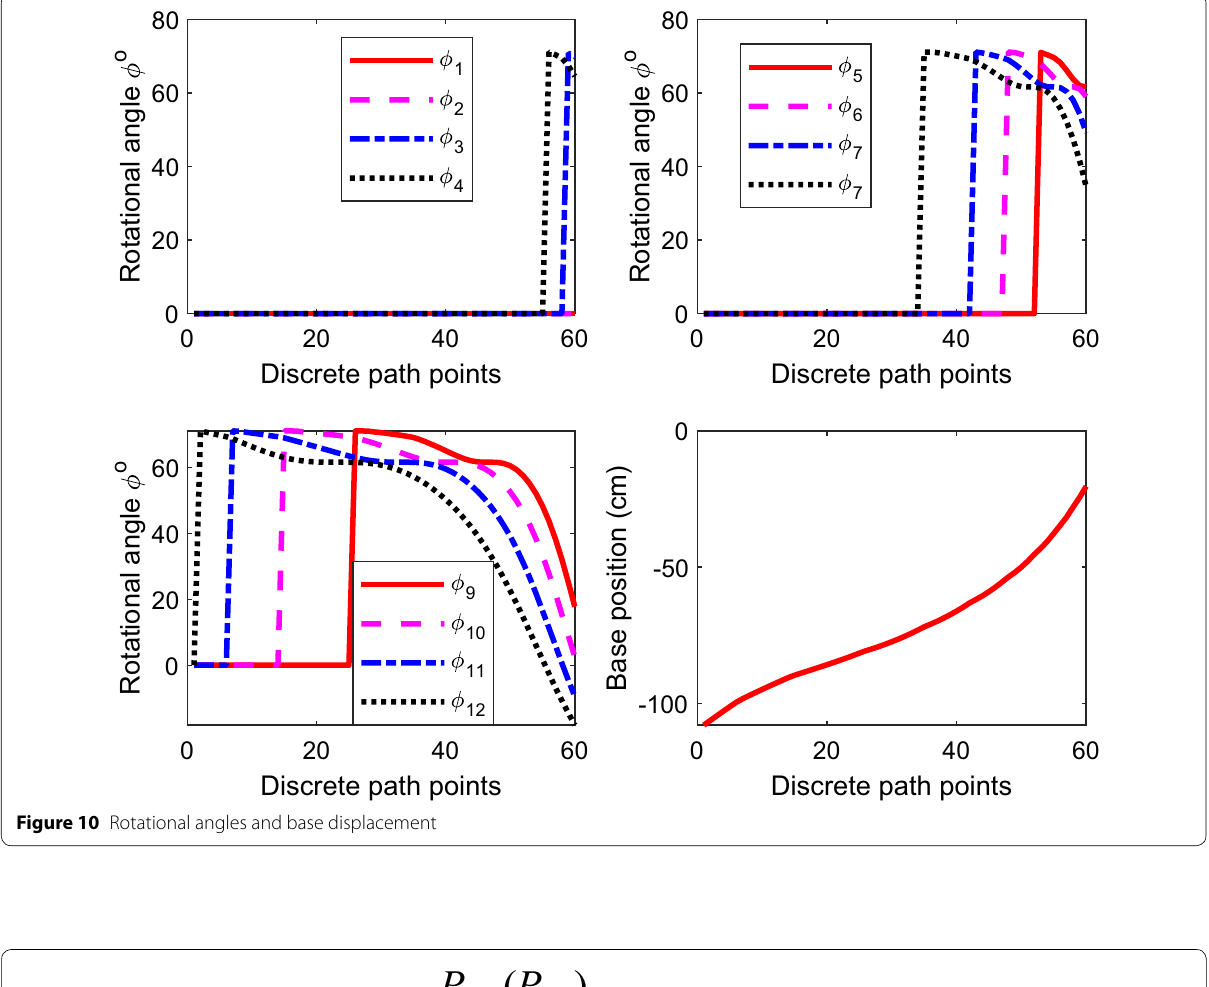
Figure 10 Rotational angles and base displacement